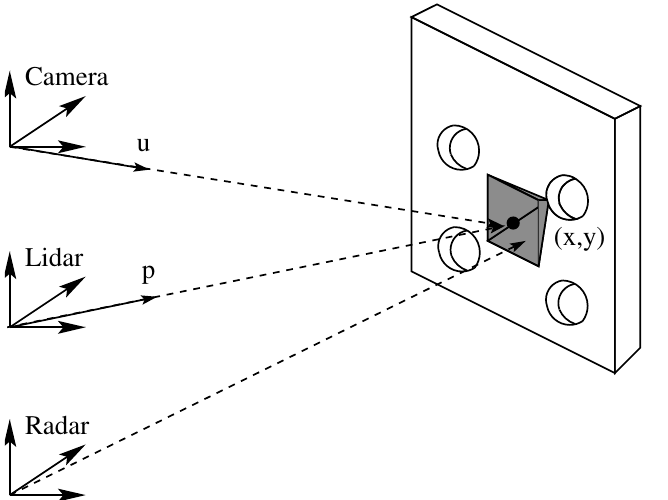
Figure 5. The figure shows the lidar and radar frames detecting the board center and the corner reflector, respectively.